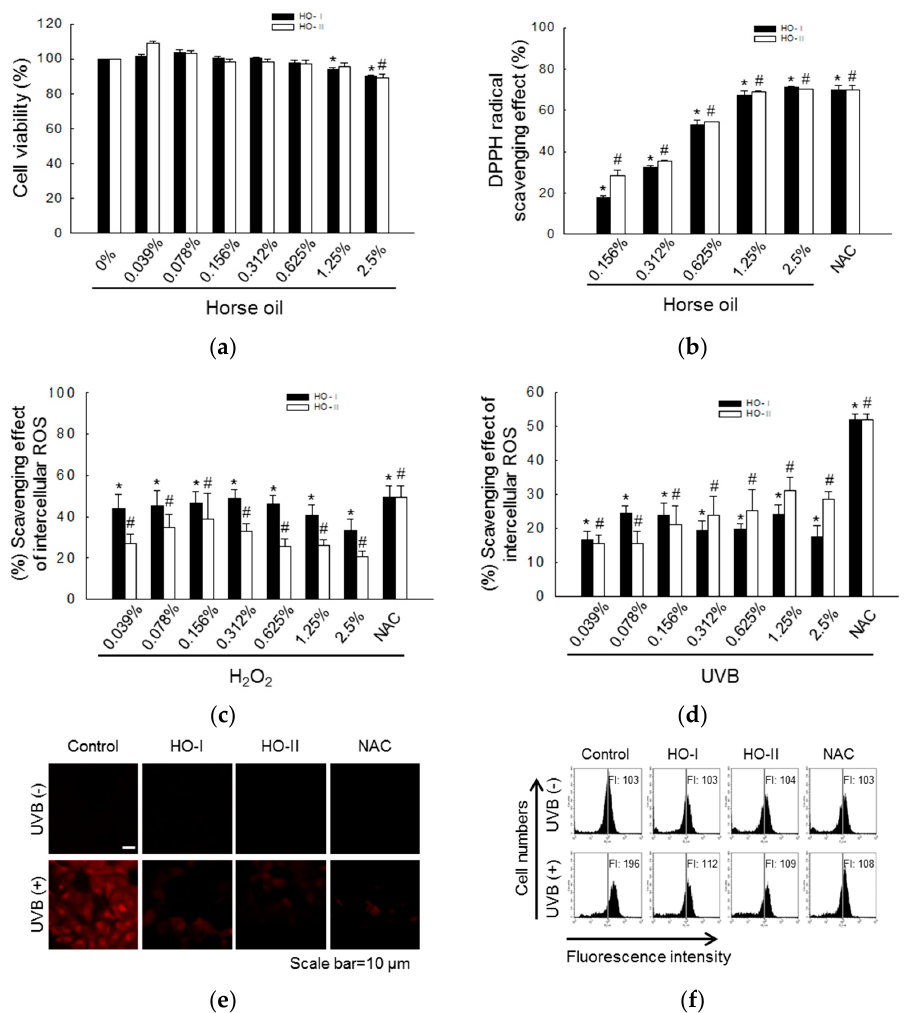
Figure 1. Horse oil can scavenge stress-induced ROS. ( a ) Horse oil (HO-I or HO-II) was added at the indicated final concentrations. After 24 h, cell viability was measured by MTT assay. ( b ) DPPH radical levels were measured spectrophotometrically at 520 nm. *, # p < 0.05 vs. non-treated control cells. Intracellular ROS levels generated by ( c ) H 2 O 2 or ( d ) UVB radiation were detected by spectrofluorometry after H 2 DCFDA staining. NAC served as a positive control. * p < 0.05 vs. H 2 O 2 alone, and # p < 0.05 vs. UVB alone. Cells were treated with 0.312% horse oil for 1 h, and then with UVB radiation at 30 mJ/cm 2 . Next, the cells were incubated for 24 h, and intracellular ROS were detected by ( e ) confocal microscopy (Scale bar = 10 µ m) and ( f ) flow cytometry after H 2 DCFDA